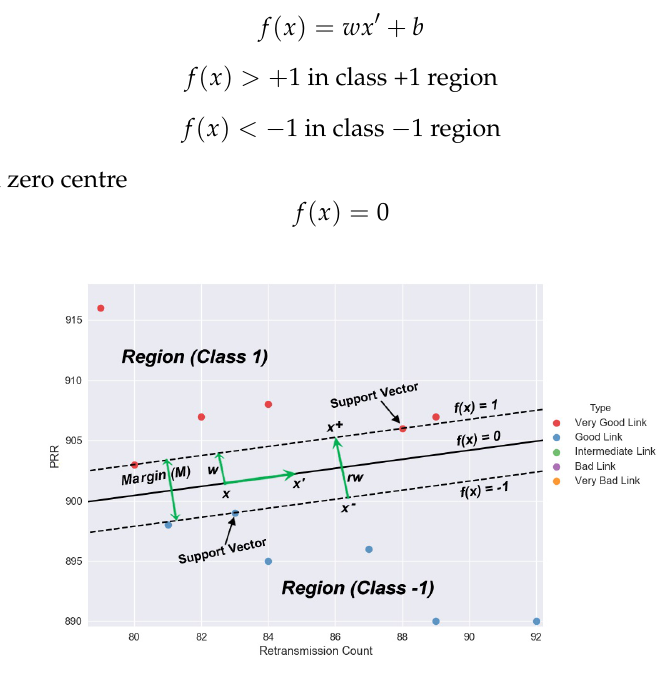
Figure 3. KLSVM: A modeled decision boundary obtained from the real dataset. The hyperplane separates two regions of the Very Good Link and the Good Link data points. The plot shows that the proposed method proves the accurate performance of the